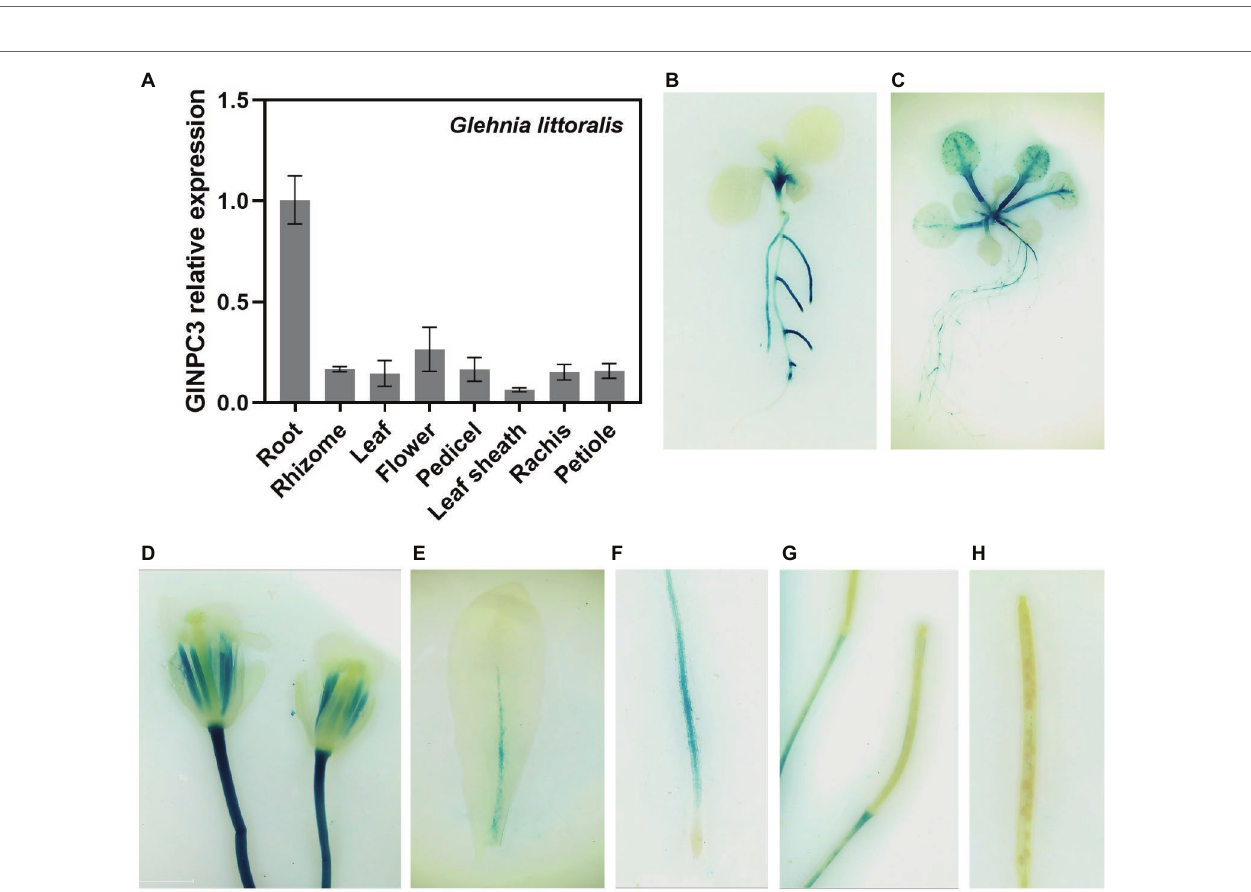
FIGURE 4 | Expression pattern of GlNPC3 in plants. (A) Tissue-specific expression analysis of GlNPC3 in G. littoralis . Data represent means ± SD of three biological replicates with three pooled tissues (plants) each. GlEXP1 was used as the internal control. (B–H) Histochemical GUS-staining of transgenic A. thaliana (Promoter GlNPC3 ::GUS). Histochemical GUS-stained 4-day-old seedling (B) , 10-day-old seedling (C) , flower (D) , old leaf (E) , root (F) , and siliques (G,H) are